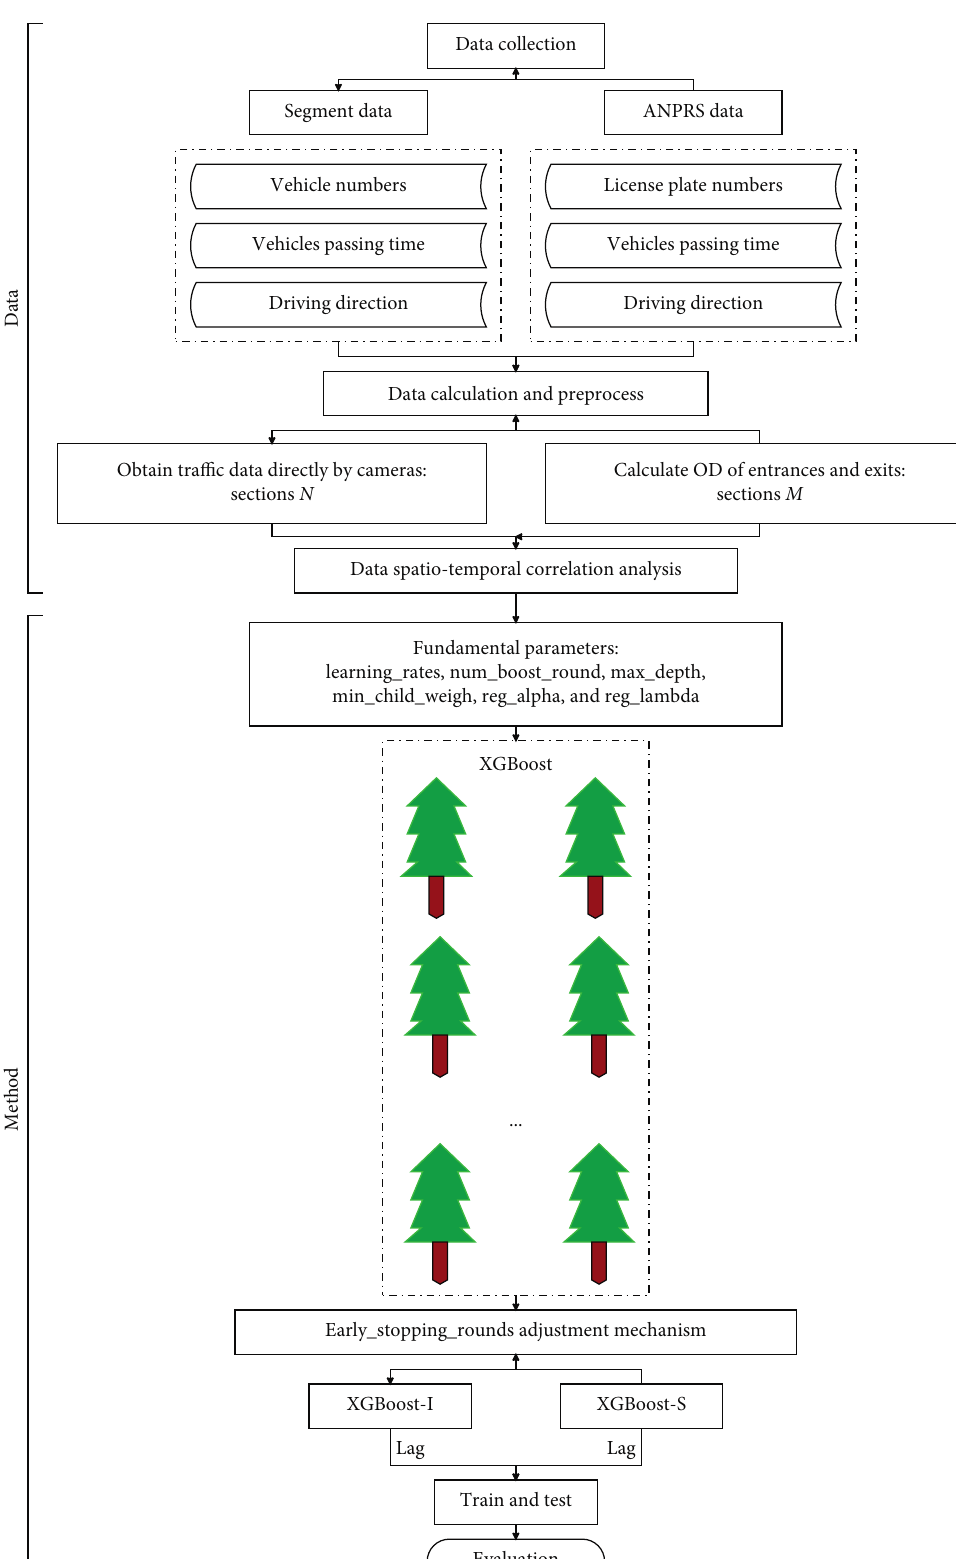
Figure 1: Methodology